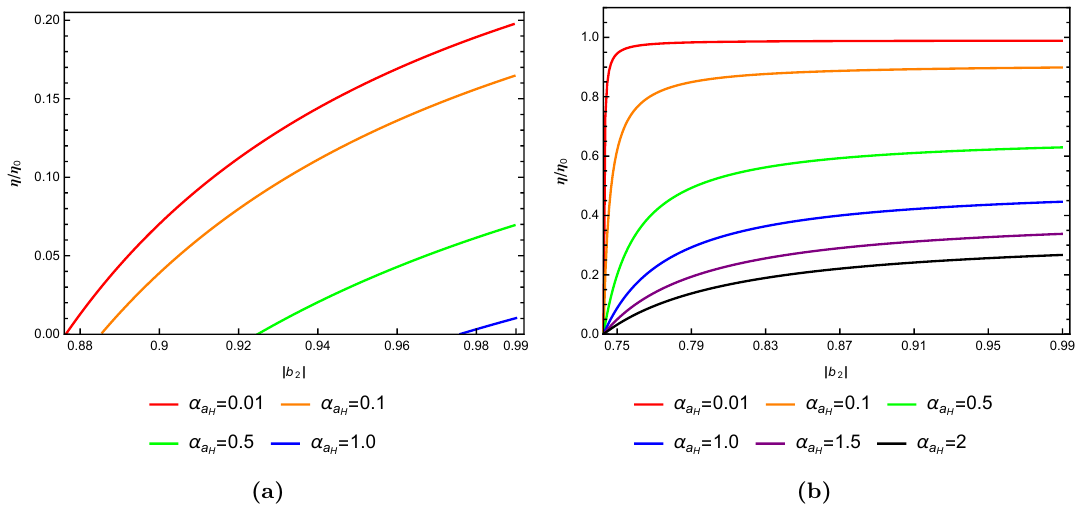
Figure 9. η/η 0 is plotted with respect to | b 2 | for different values of α a and (b) are for A = 0 . 5 and A = 5 . 0 ,